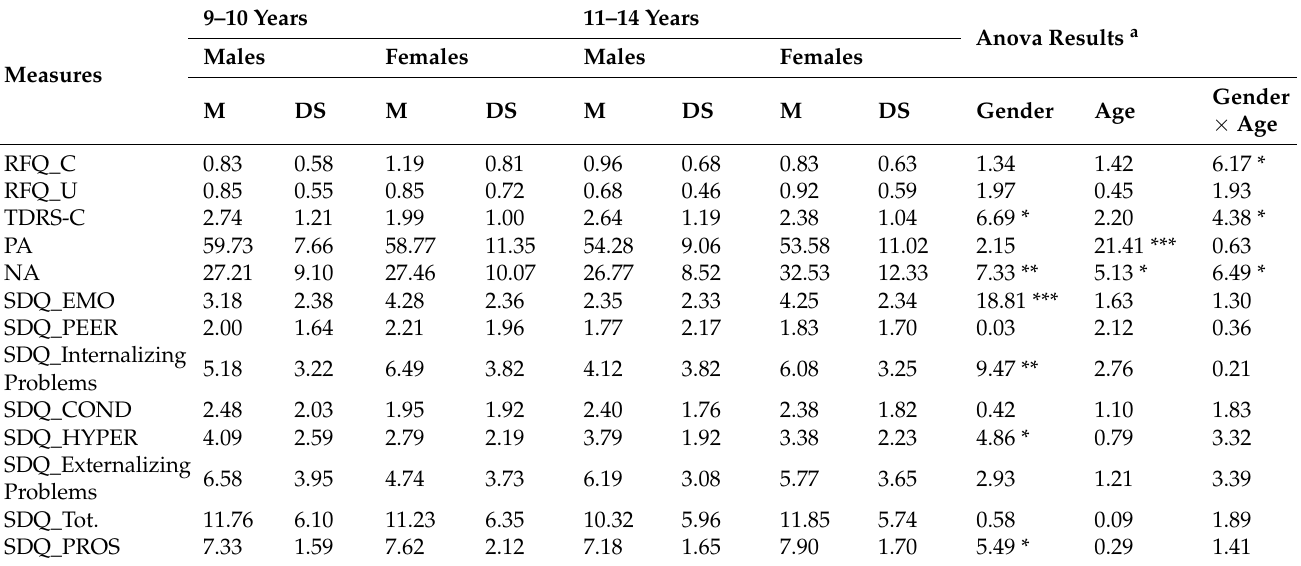
Table 4. Descriptive statistics of study variables by gender and age groups with ANOVA results (comparison group, n =